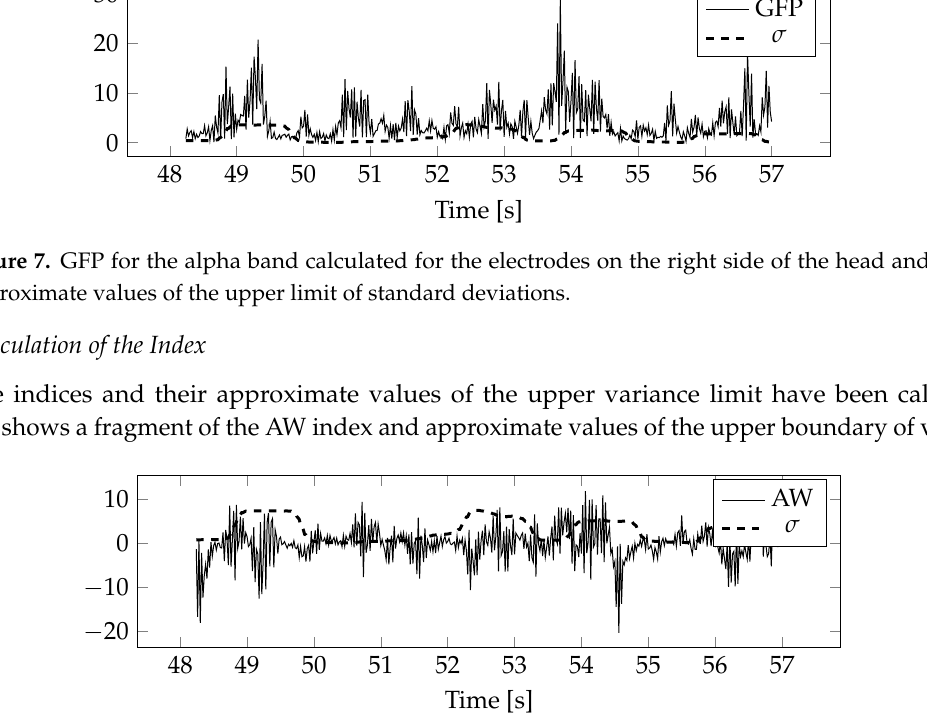
Figure 8. Index AW and its approximate values of the upper limit of standard deviations.